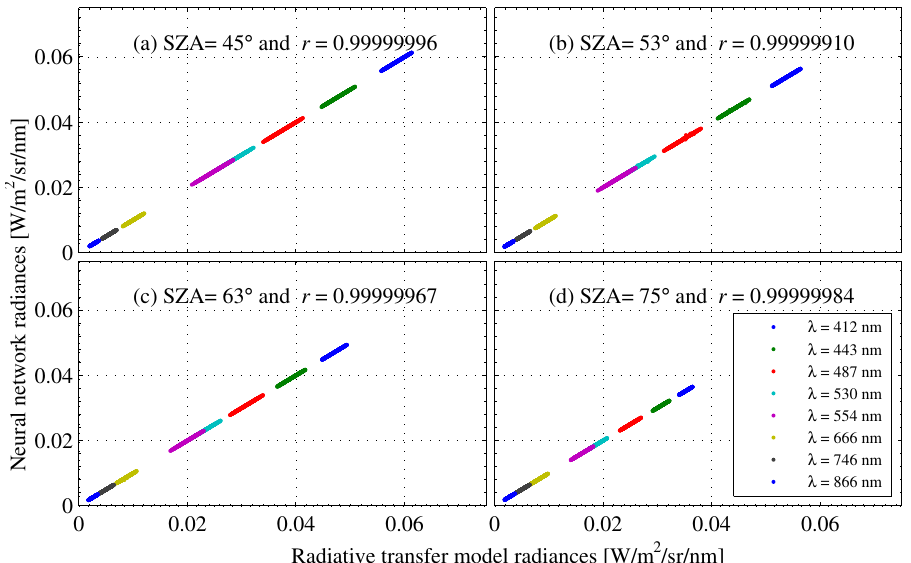
Figure 2. Comparison between radiances obtained from the RBF-NN and those obtained from a well-tested radiative transfer model (RTM) for a coupled atmosphere-ocean system (viewing angle θ = 0 ◦ ). Note that in graphs ( a – d ) both the shortest wavelength (412 nm) and the longest wavelength (866 nm) are represented by the blue color, and that the higher radiance values corresponds to 412